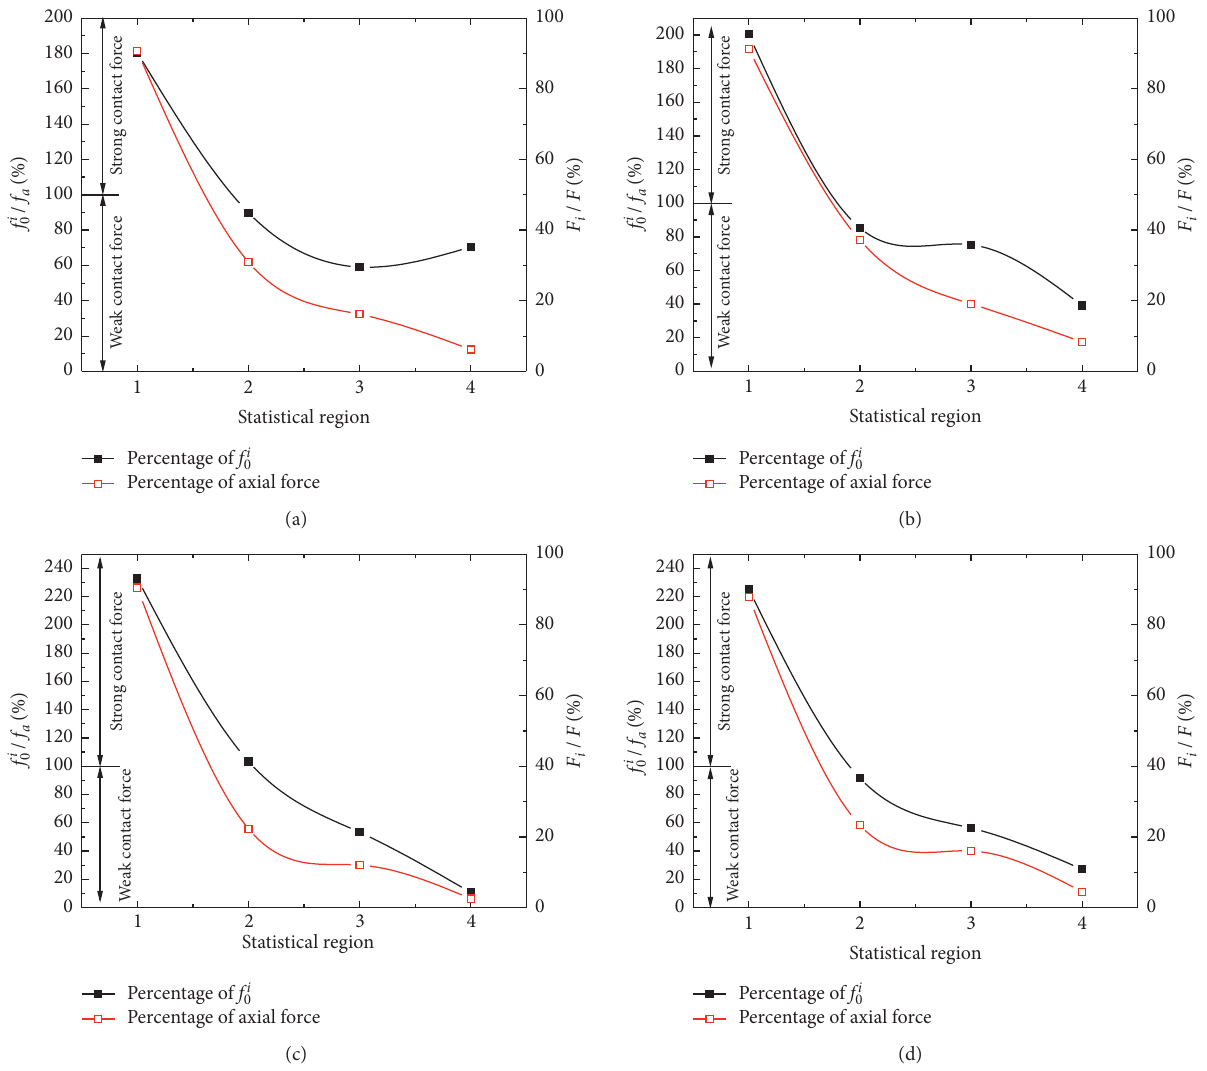
Figure 10: Comparison of the particle system contact force chain and geogrid axial force transmission of BG1 in different statistical zones divided longitudinally along the geogrid. (a) Normal stress � 20kPa. (b) Normal stress � 30kPa. (c) Normal stress � 40kPa. (d) Normal stress �